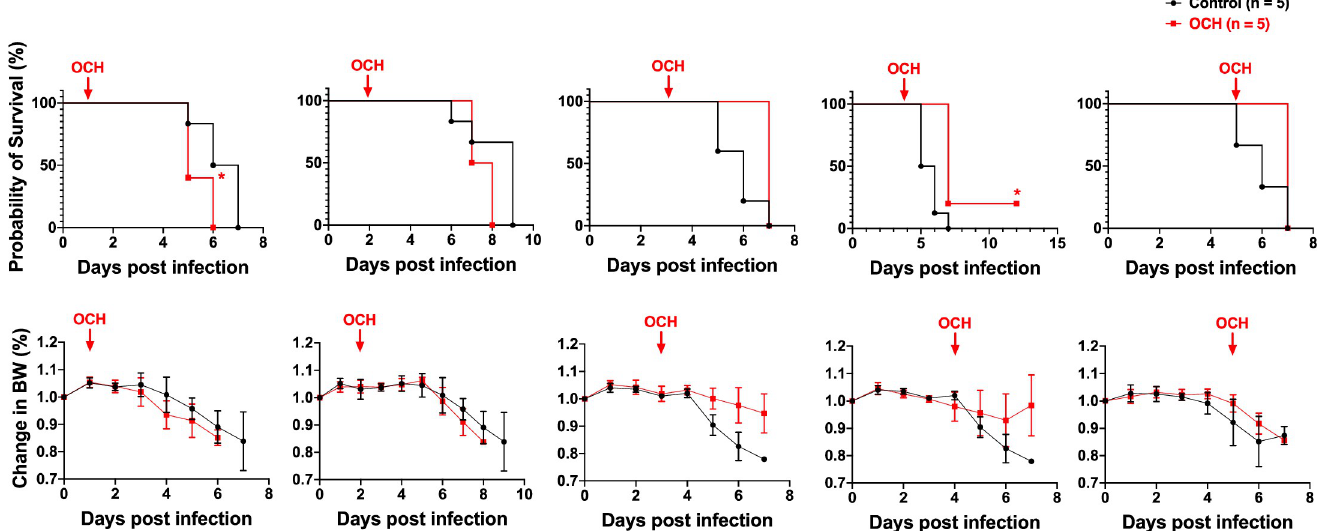
Fig 10. α -GalCer analog, OCH, only demonstrates therapeutic benefits in late stages of SARS-CoV-2 infection. hACE2-Tg mice (n = 5) were infected with SARS-CoV-2 (Isolate USA-WA1/2020, 1X10e4 pfu per mouse). Three micrograms of OCH glycolipids were administered to infected mice at different time points post infection, from day 1 to day 5. Mouse body weight (BW) changes and survival were tallied and compared. Statistical analyses of mouse survival were performed using Mantel-Cox log-rank test. * p < 0.05.